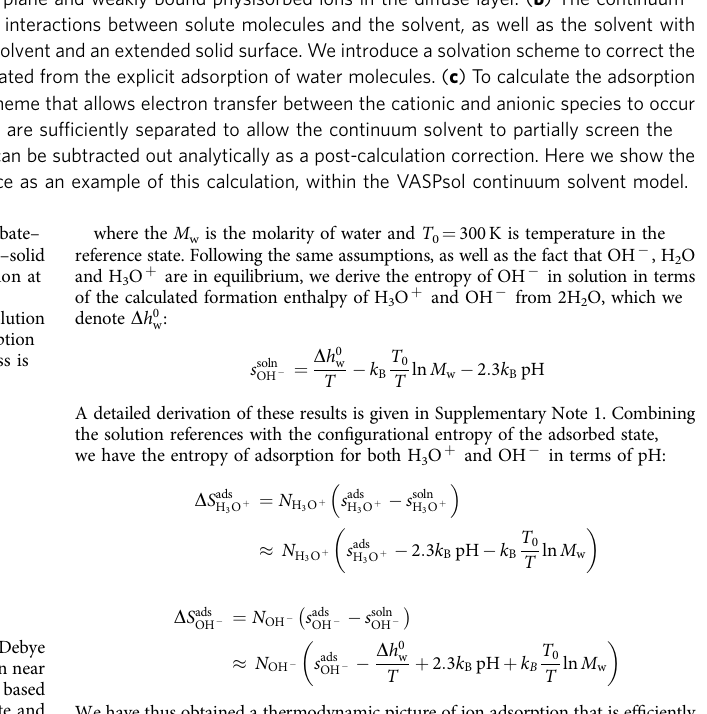
Figure 4 | Scheme for computing the free energy of an aqueous interface. ( a ) The structure of an electrostatic double layer, consisting of a space charge in the solid, a tightly bound chemisorbed layer within the Helmholtz plane and weakly bound physisorbed ions in the diffuse layer. ( b ) The